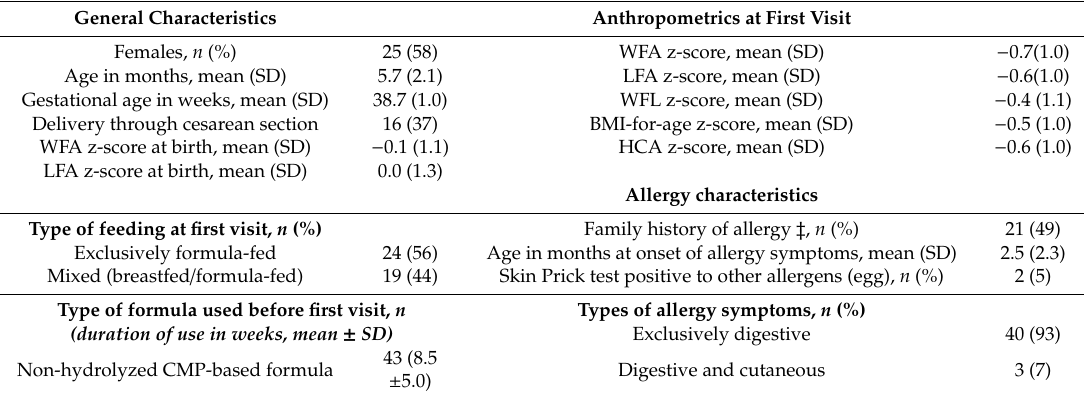
Table 1. Characteristics of the 43 included patients.